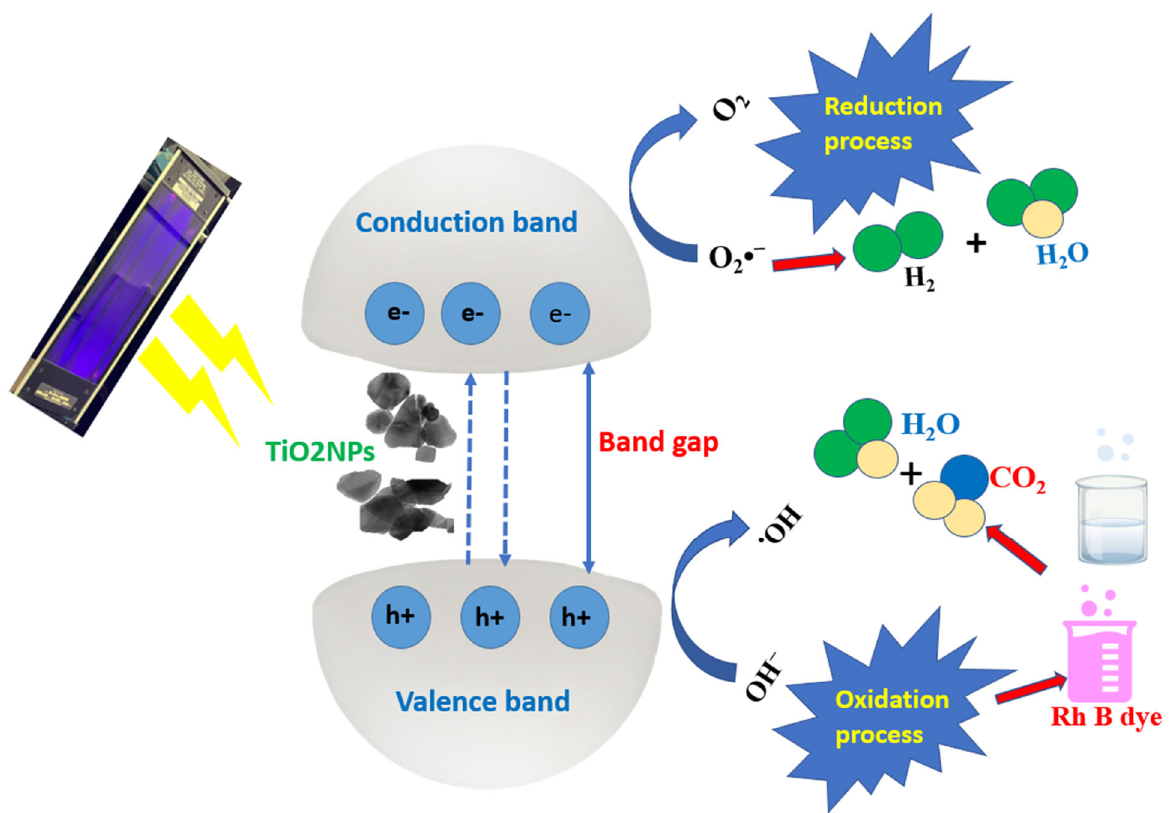
Figure 7. Illustration of the mechanism of photocatalysis, proving degradation of Rh B pollutant dye using synthesized TiO 2 NPs as photocatalysts.